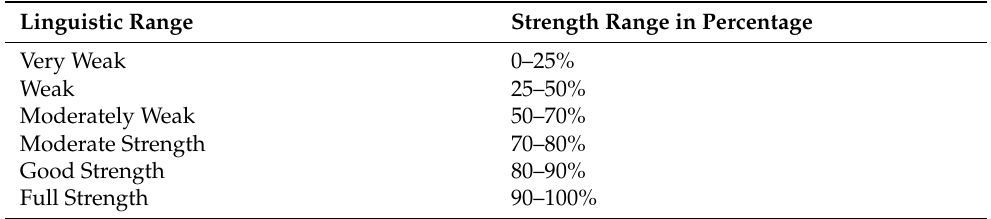
Table 4. The defined strength